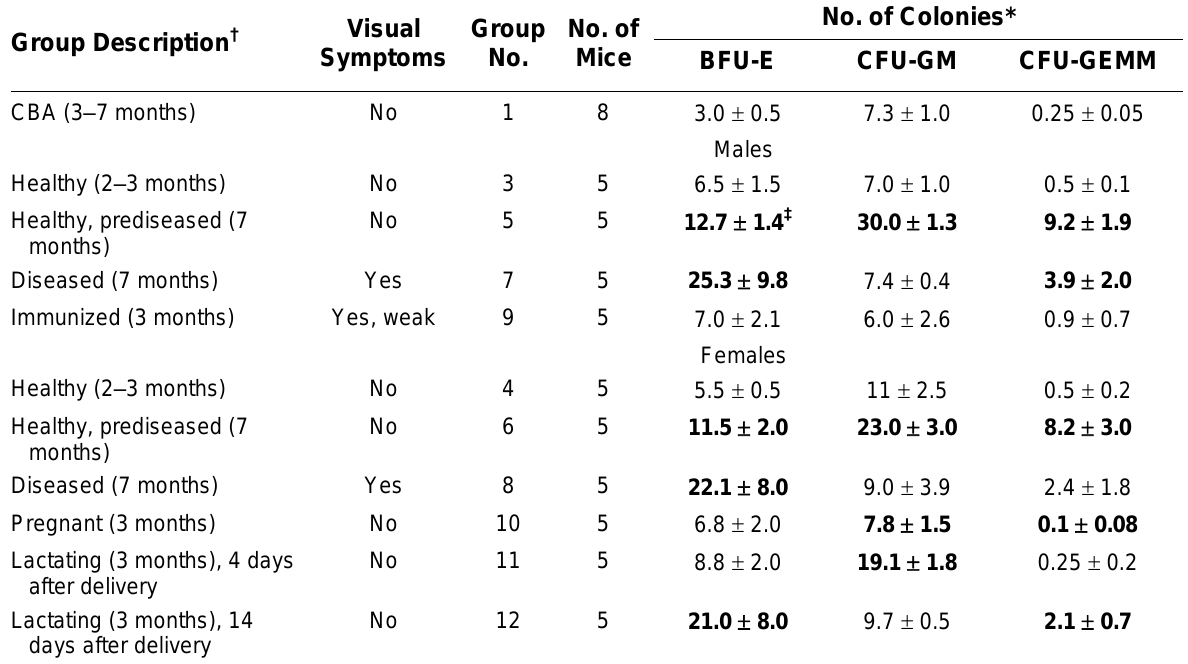
Formation of Bone Marrow Progenitor Colonies in Autoimmune-Prone MRL-lpr/lpr and Control Nonautoimmune